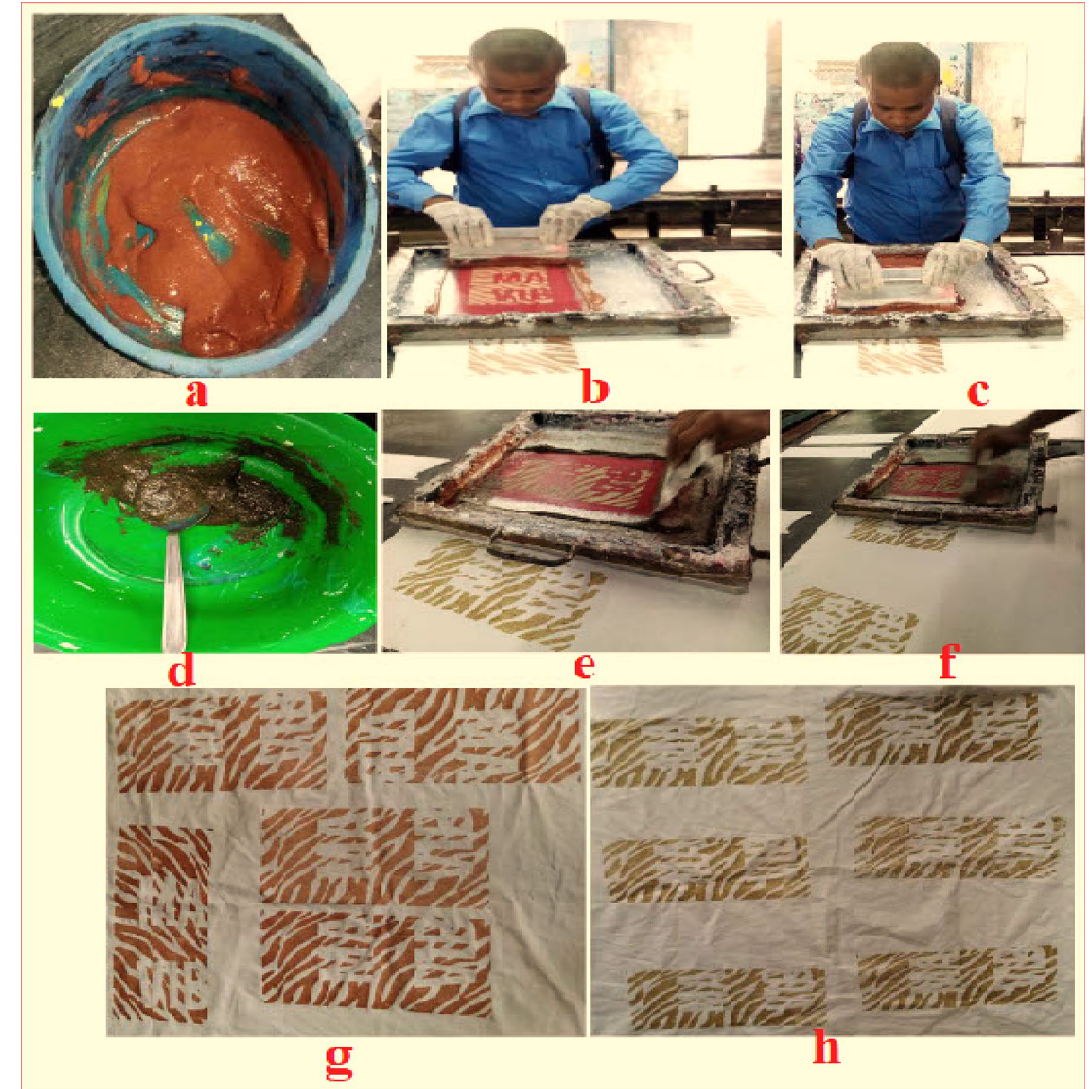
Figure 1. Preparation and laboratory process for coating and printing with NPND- Swietenia Macrophylla and NPND- Corchorus Capsularis